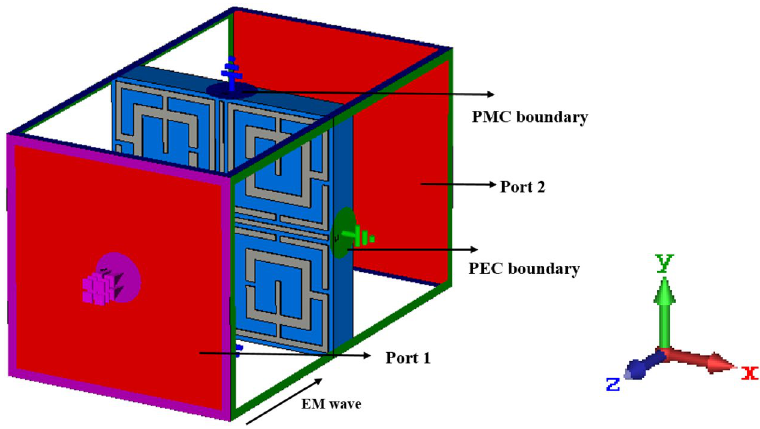
Figure 2. Simulation setup for performance evaluation of the unit cell (CST STUDIO SUITE 2019, https:// www. 3ds. com/ produ cts- servi ces/ simul ia/ produ cts/ cst- studio- suite) 42 .